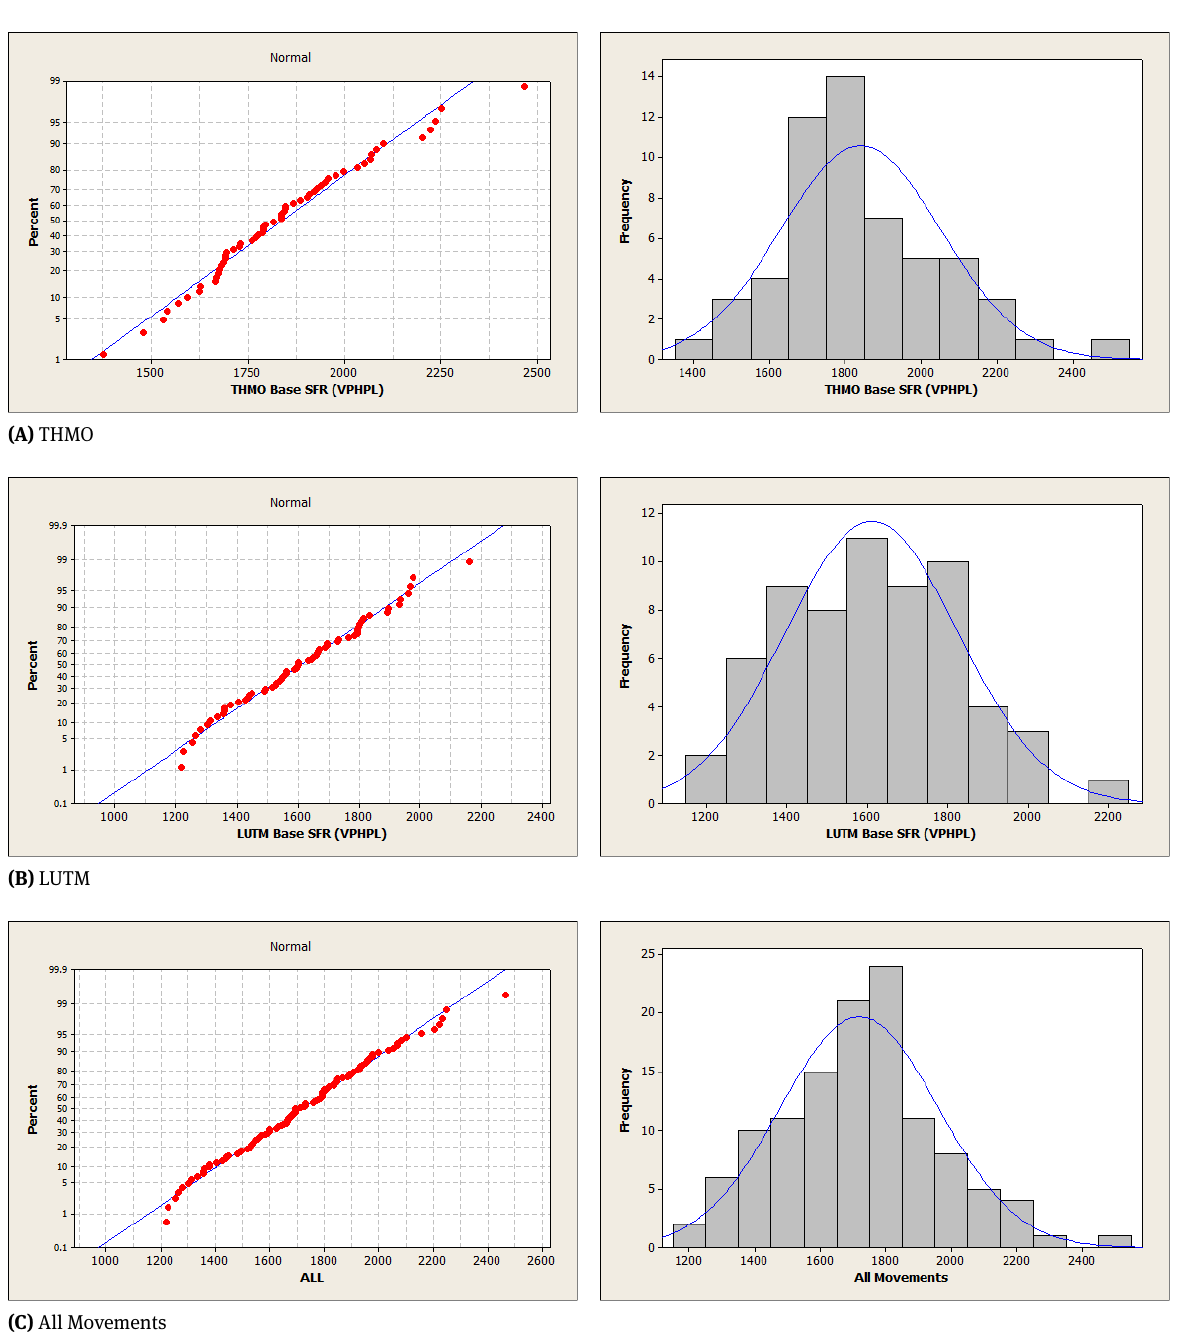
Figure 2: Statistical Base SFR Summary for (A) THMO, (B) LUTM, (C) All Movements.